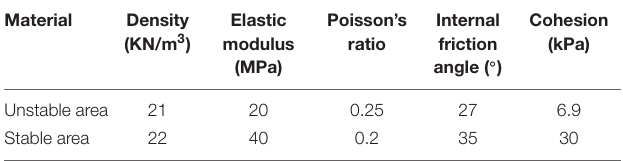
TABLE 2 | Physical and mechanical parameters of the slope. Material